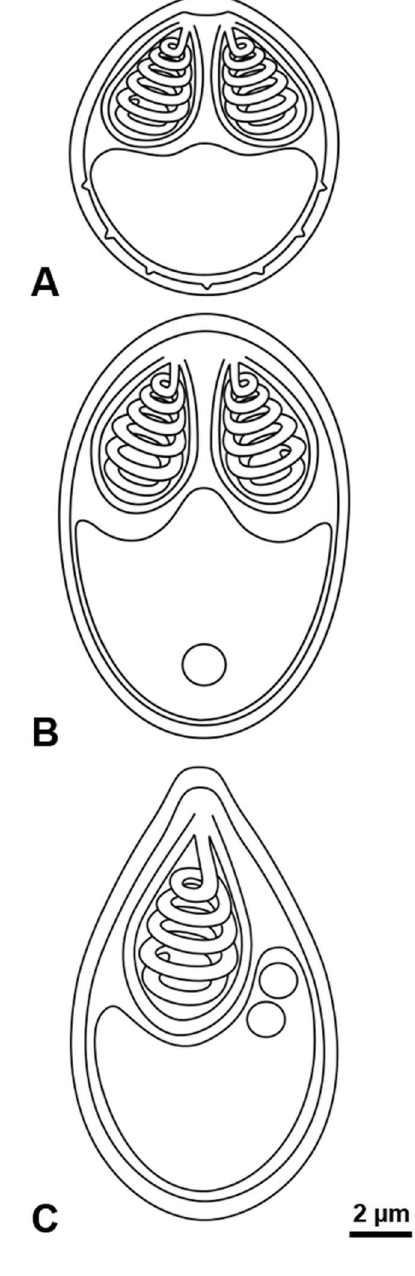
Figure 2. Schematic drawings of the new myxobolid species found infecting Iberian endemic cypriniforms; myxospores drawn in valvular view. (A) Myxobolus arcasii n. sp. (B) Myxobolus duriensis n. sp. (C) Thelohanellus paludicus n.